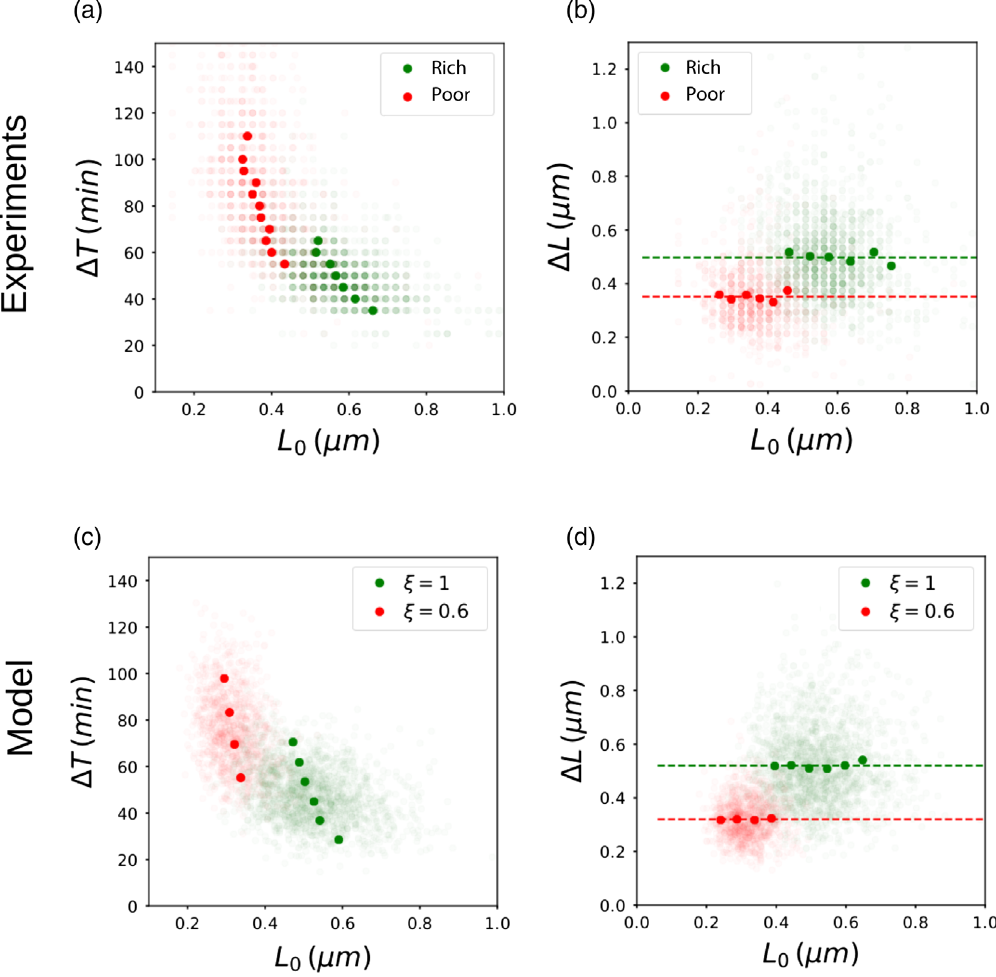
FIG. 8. Comparison between experiments and model results. (a) Division time Δ T versus the cell size at birth L 0 from the mother machine experiment for rich and poor nutrient conditions. Each lighter dot represents a single cell cycle data. Darker dots are bin averages. (b) Elongation Δ L versus L 0 for the same experiments as in (a). (c),(d) The same plots as (a) and (b), respectively, from Z Þ as in Fig. 5 is used. See Appendix B for details on the numerical simulations of our model. The same P d ð